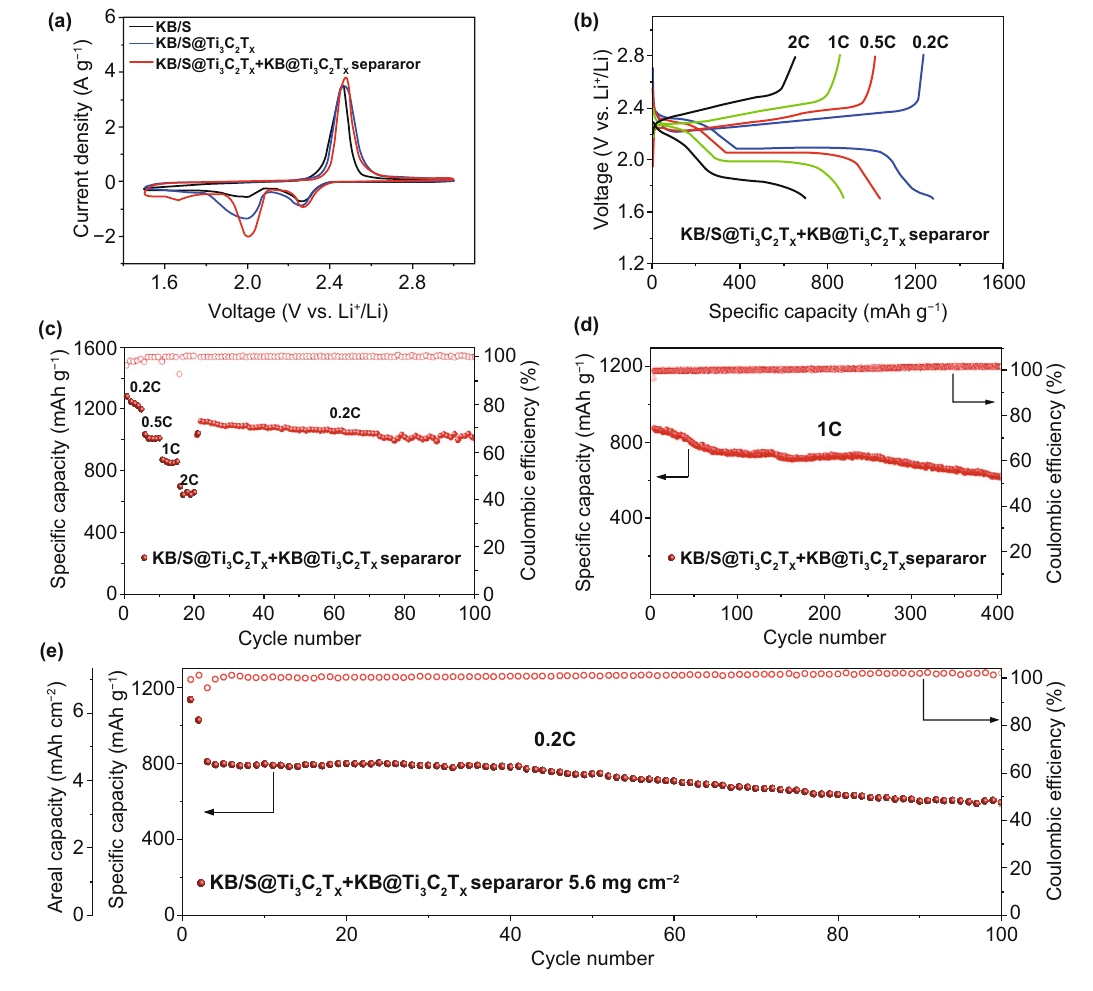
Fig. 5 a CV profiles of KB/S and KB/S@Ti 3 C 2 T x , with the pristine separators, and the KB/S@Ti 3 C 2 T x electrode with the KB@Ti 3 C 2 T x modi- fied separator. b Voltage profiles of the KB/S@Ti 3 C 2 T x cell with the KB@Ti 3 C 2 T x modified separator at various rates ranging from 0.2 to 2 C. c Rate performances, d long-term cycling performance at 1 C of the KB/S@Ti 3 C 2 T x electrode with the KB@Ti 3 C 2 T x separator. e Cycling perfor- mance with high sulfur loading of 5.6 mg cm −2 at 0.2